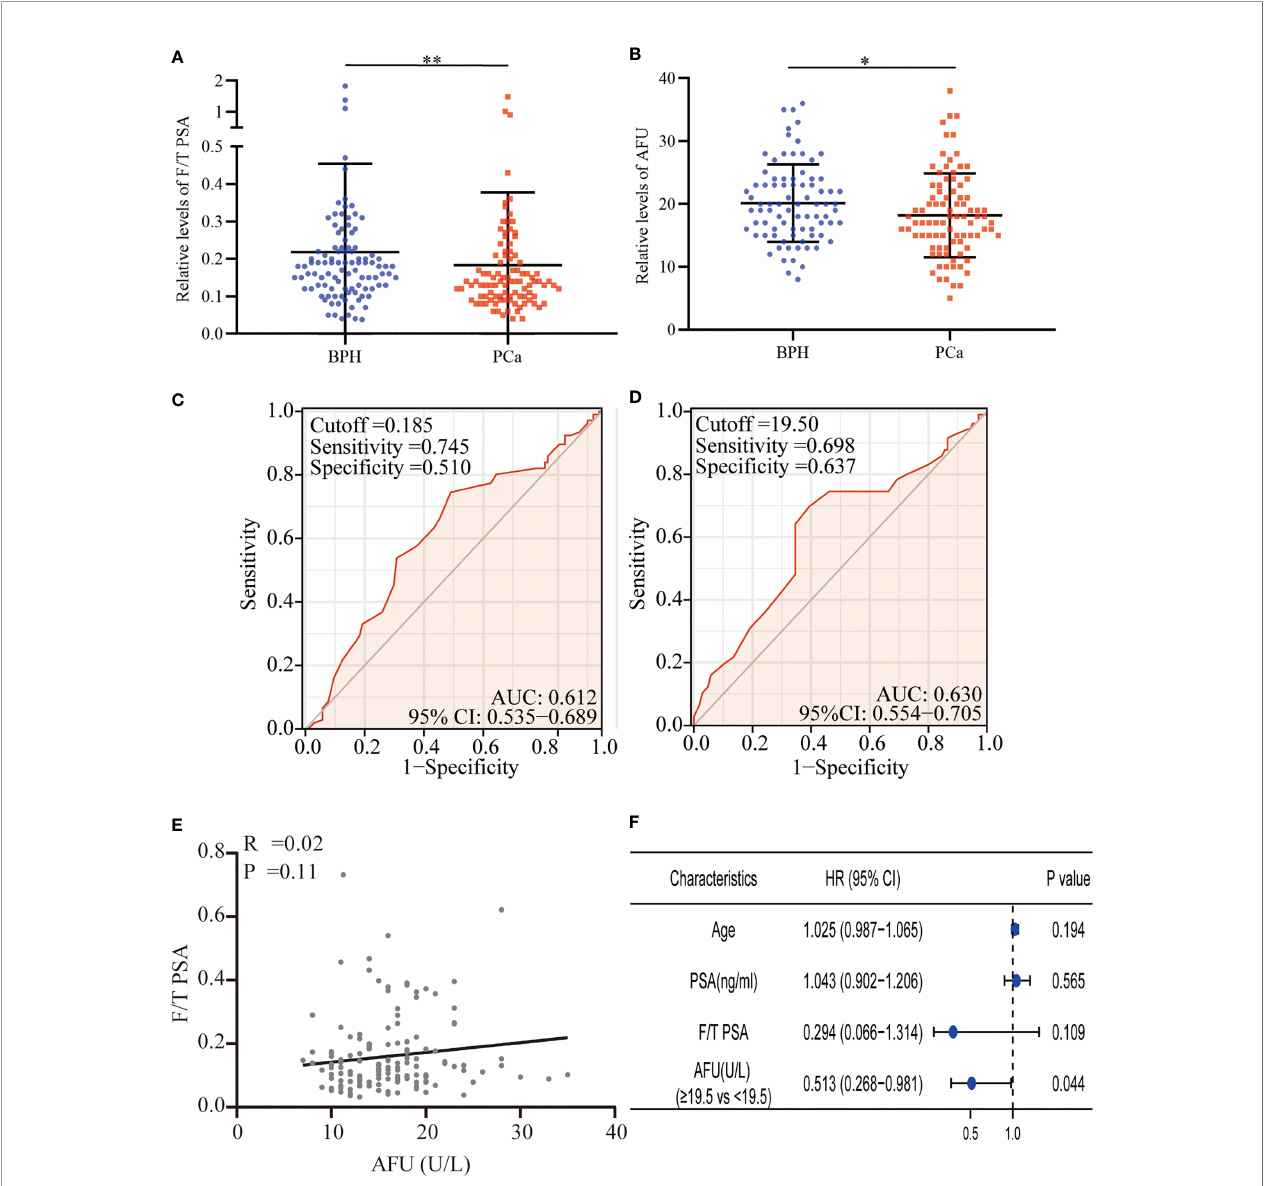
FIGURE 1 | F/T PSA and AFU level in BPH and PCa. (A) F/T PSA level. (B) AFU level. (C) The diagnostic value of F/T PSA for PCa. (D) The diagnostic value of AFU for PCa. (E) The line correlation between F/T PSA and AFU. (F) Logistic analysis of AFU expression for the PCa diagnosis; * p < 0.05, ** p < 0.01. F/T PSA, free/total prostate-speci fi c antigen; AFU, alpha- L -fucosidase; BPH, benign prostatic hyperplasia; PCa, prostate